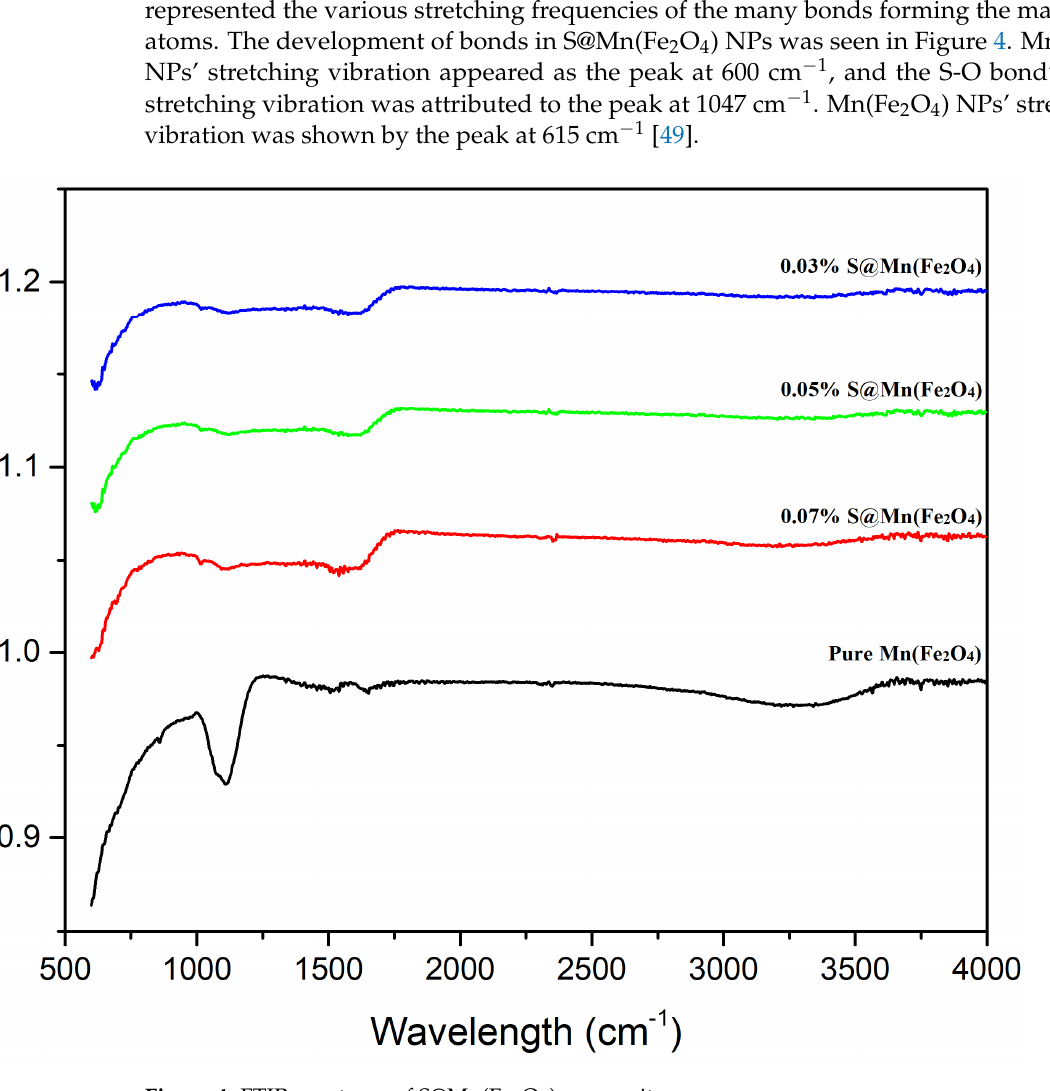
Figure 4. FTIR spectrum of S@Mn(Fe 2 O 4 )